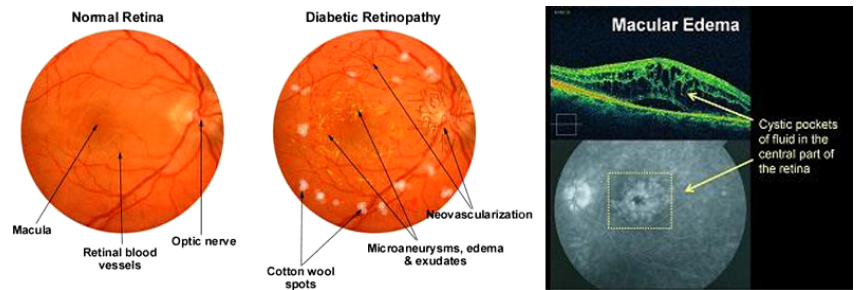
Fig. 1. An illustration for diagnosis of